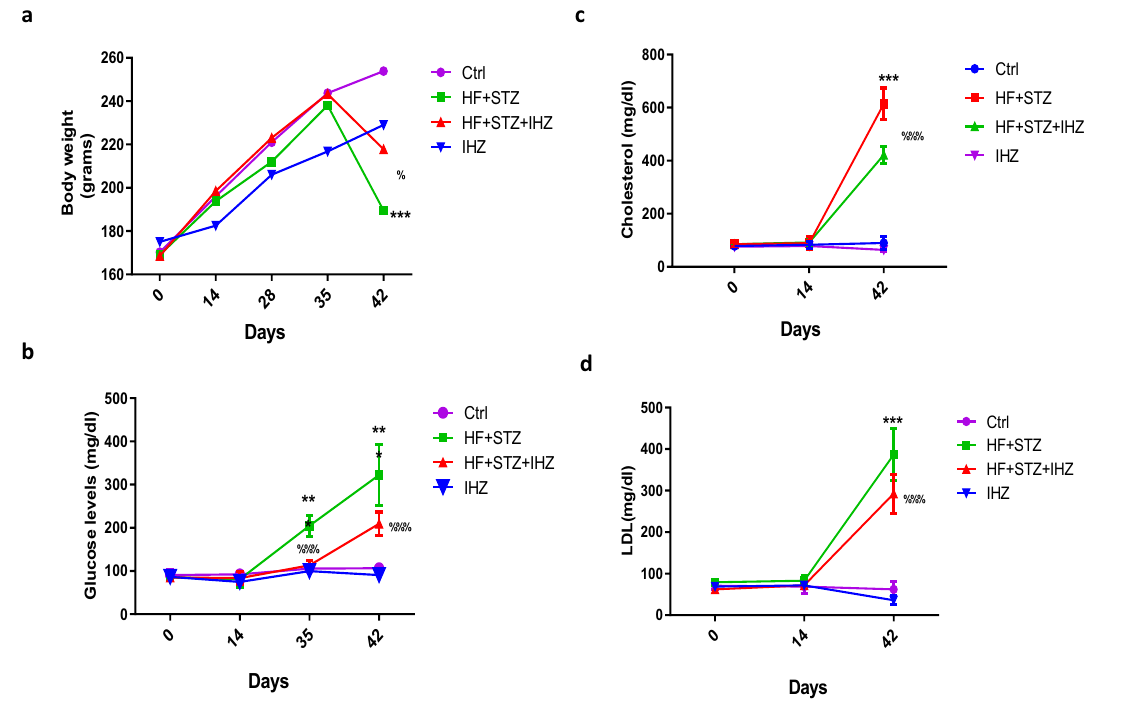
Figure 1. IHZ attenuates insulin resistance in HF with low STZ induced diabetic rats. Rats were fed with High Fructose (HF, 20%) water for 6 weeks and single dose of STZ (35 mg/kg, i.p.) was administered at the end of 5th week, with or without IHZ (25 mg/kg, p.o.) for 6 weeks. Analysis of body weight was done every week and biochemical parameters were carried out in plasma on 0, 14, 35 and 42 days from different animal groups. ( a ) Change in weight of animals during the study period. ( b ) Change in plasma cholesterol levels as measured using commercial kit over the course of the study on specified days. ( c ) Change in plasma glucose levels measured by glucometer on specified days. ( d ) Levels of low density Lipids (LDL) measured with commercial kit. Data is presented as mean ± SD of n = 6 animals for each group. ***P < 0.001 vs control group; %P < 0.05, %%%P < 0.001 vs HF + STZ